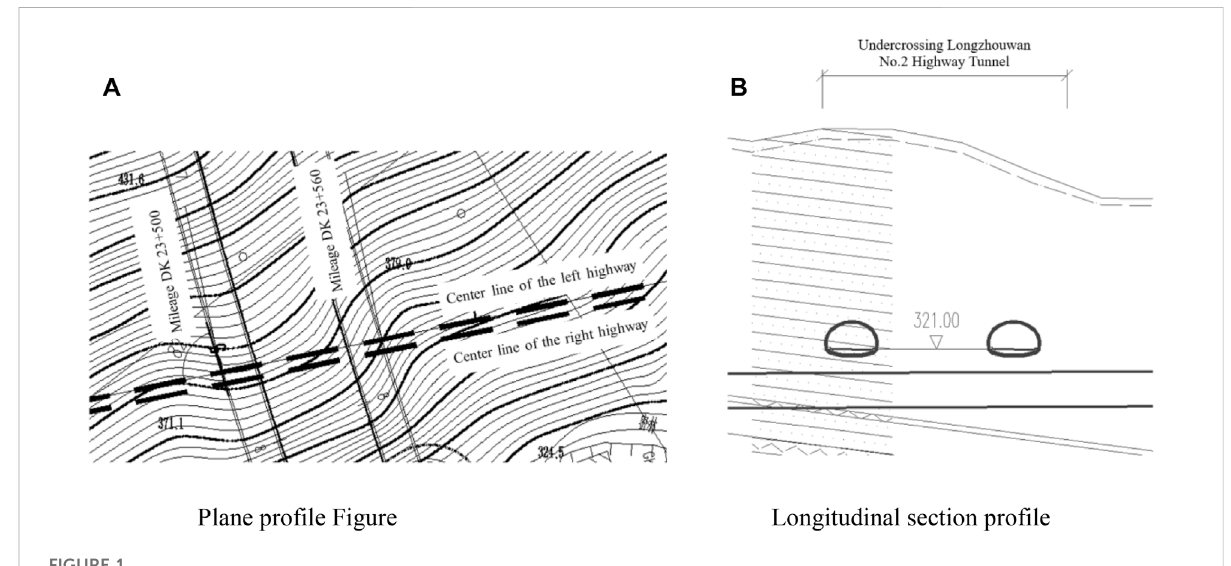
FIGURE 1 Tunnel diagram. (A) Plane pro fi le fi gure. (B) Longitudinal section pro fi